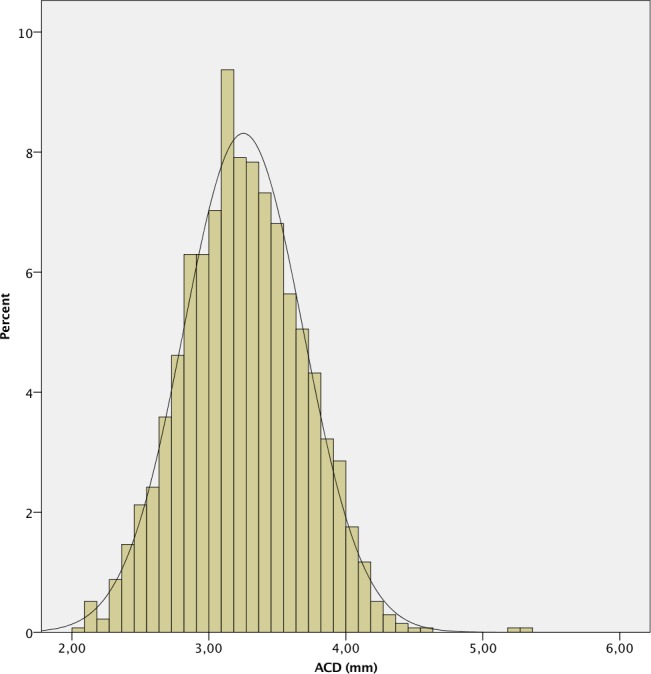
Histogram of anterior chamber depth (ACD) of the study population.